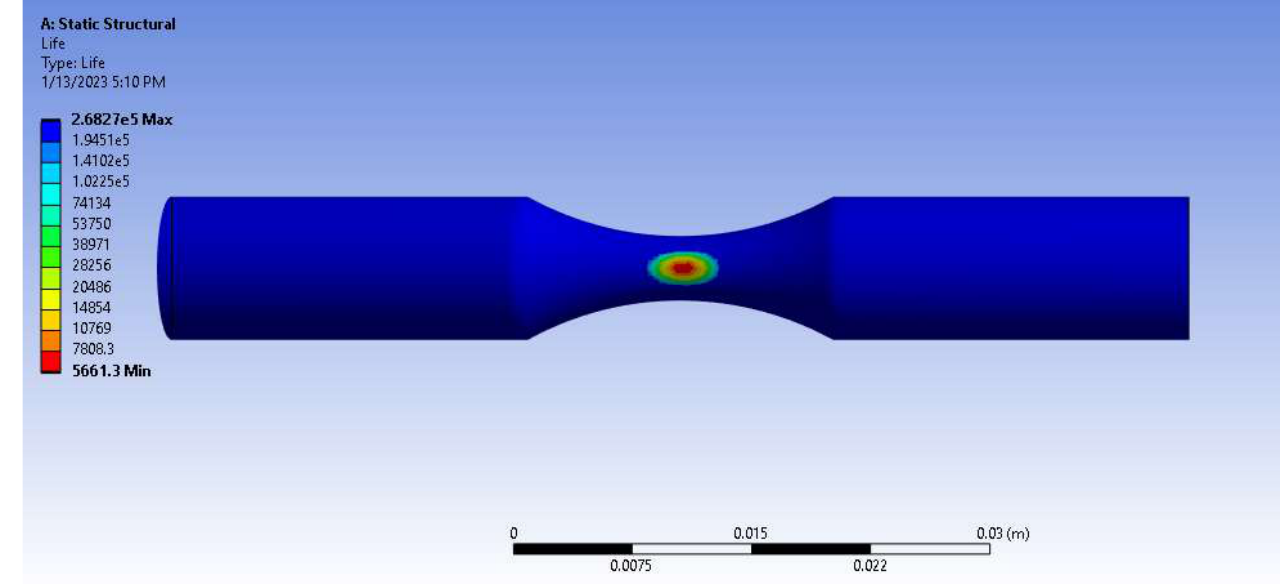
Figure 10. Nylon numerical fatigue analysis of fatigue life under 90% UTS load.